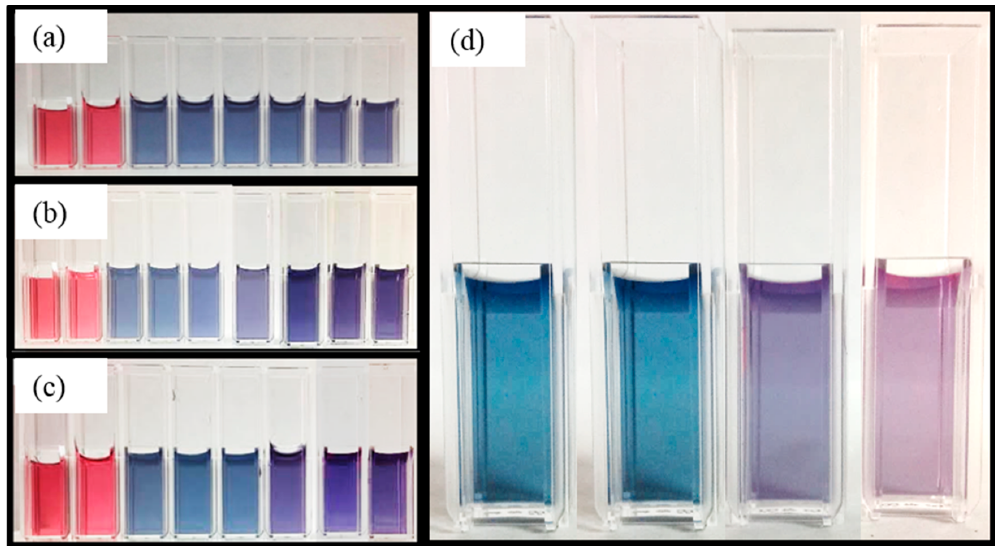
uL of 5.0% APTES. From left to right: AuNps, AuNps/ferritin, 0 min, 1 min, 3 min, 6 min, 9 min, 12 min, and 15 min ( b ) 100 uL of 1% APTES. From left to right: AuNps, AuNps/ferritin, 0 min, 1 min, 3 and 15 min ( b ) 100 µ L of 1% APTES. From left to right: AuNps, AuNps / ferritin, 0 min, 1 min, 3 min, min, 6 min, 9 min detection, 12 min, and 15 min ( c ) 100 uL of 0.5% APTES. From left to right: AuNps, 6 min, 9 min detection, 12 min, and 15 min ( c ) 100 µ L of 0.5% APTES. From left to right: AuNps, AuNps/ferritin, 0 min, 1 min, 3 min, 6 min detection, 9 min, and 15 min. ( d ) 80 uL of 0.2% APTES. AuNps / ferritin, 0 min, 1 min, 3 min, 6 min detection, 9 min, and 15 min. ( d ) 80 µ L of 0.2% APTES. From From left to right: 0 min, 1 min, 3 min detection, and 6 min. left to right: 0 min, 1 min, 3 min detection, and 6